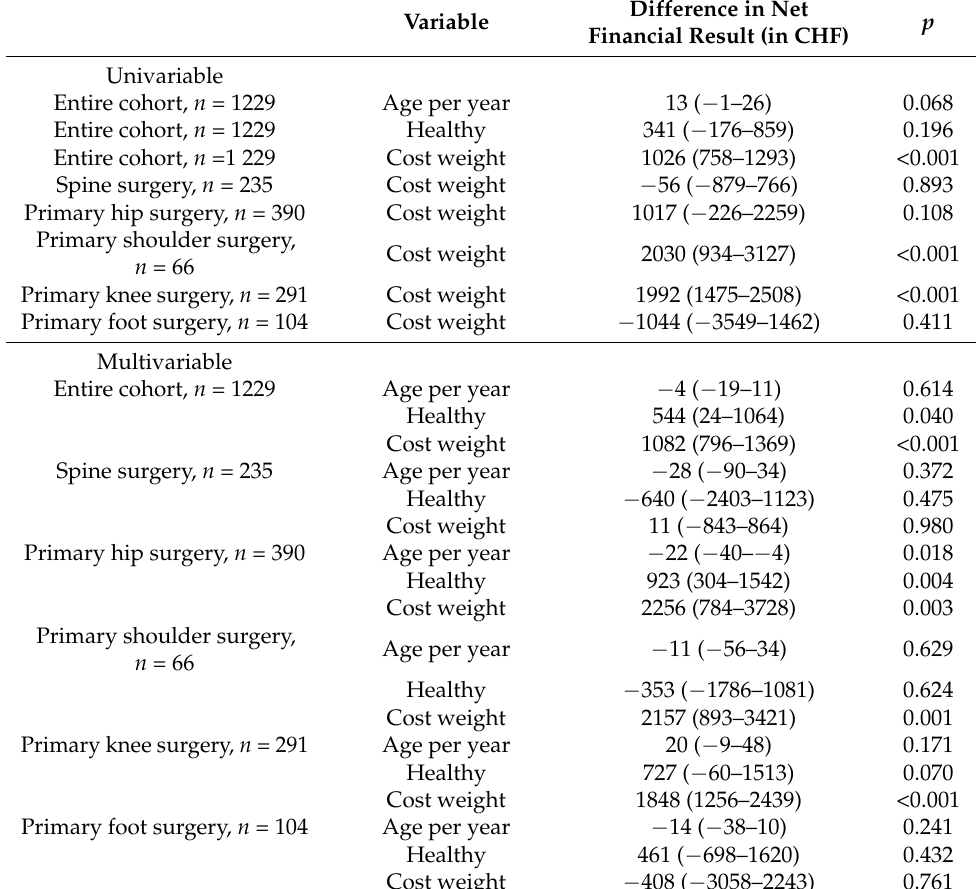
Table 3. Univariable and Multivariable analysis. Effect of each variable on net financial results.